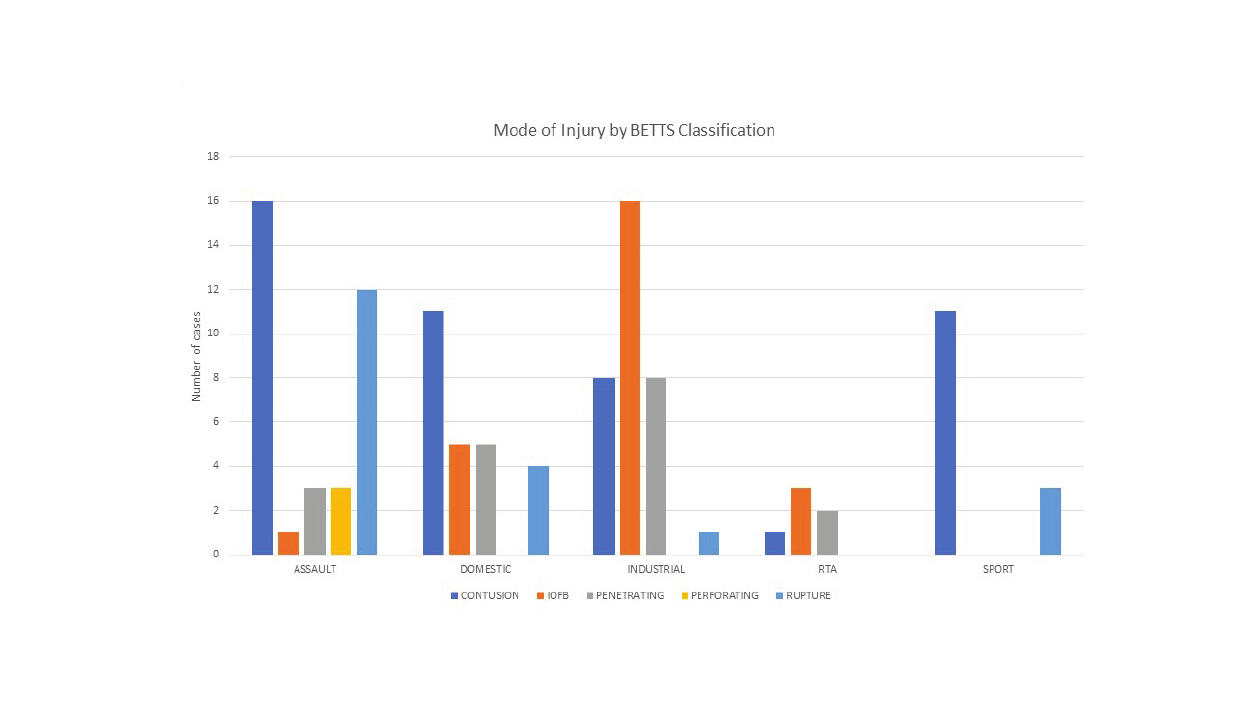
Figure 1. Histograms showing BETTS classified type of injury in each mode of injury. This demonstrates increased frequency of contusion injuries in those suffering an assault and an increased incidence of intraocular foreign bodies in industrial injuries.